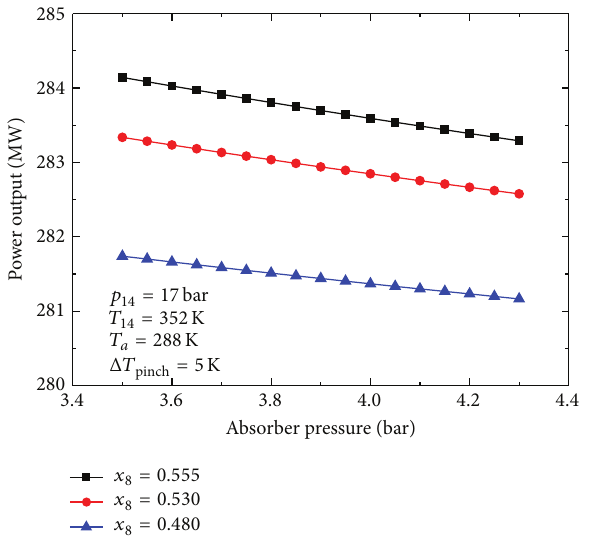
Figure 3: Variation of overall efficiency of combined cycle with absorber pressure.